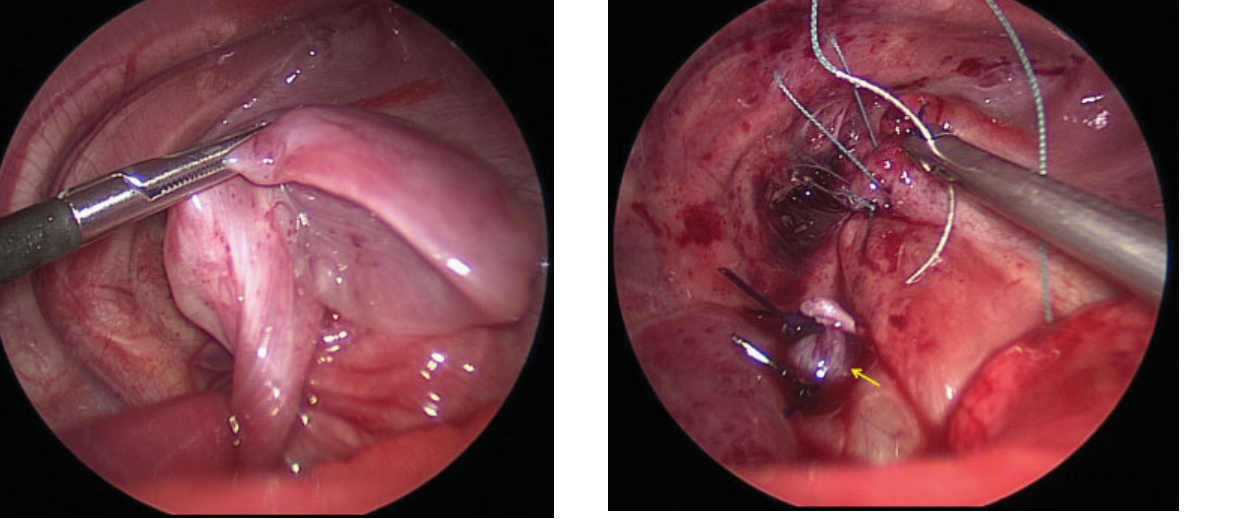
European Journal of Pediatric Surgery Reports Vol. 4 No.